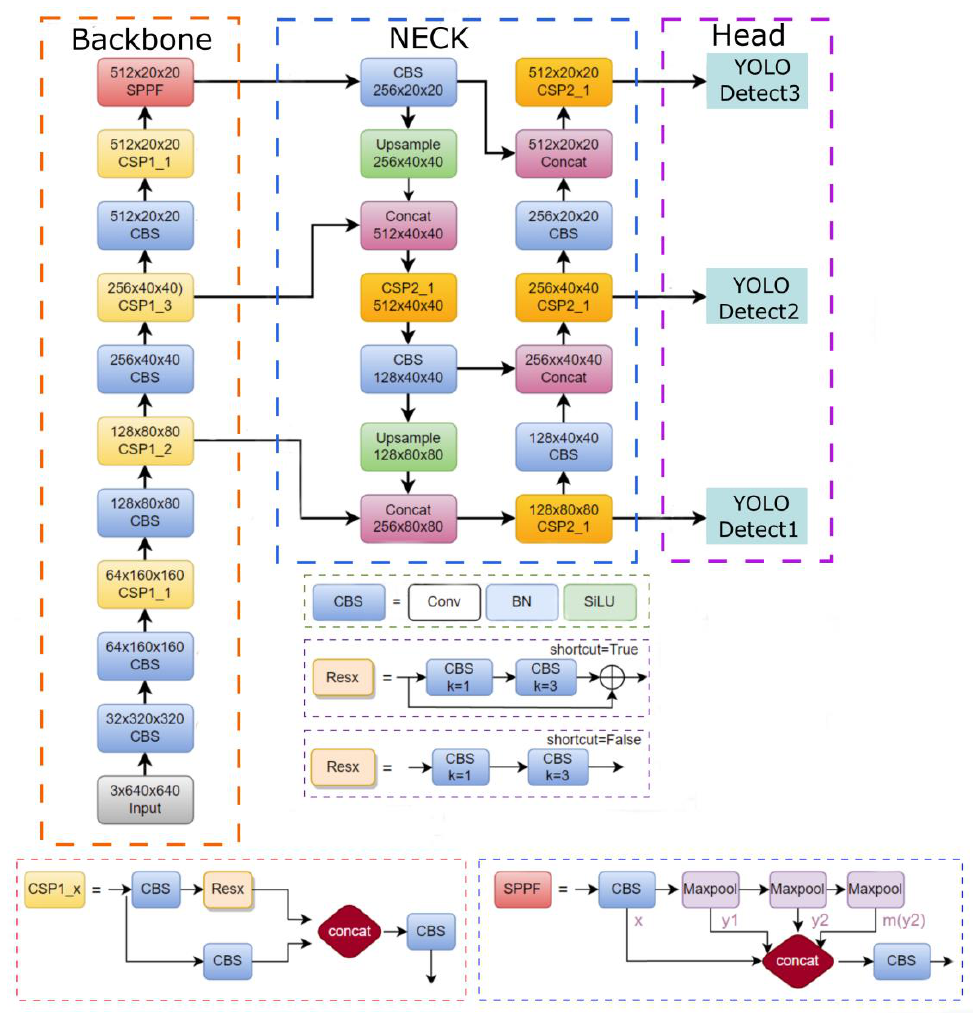
Figure 6. Architecture of YOLOv5.